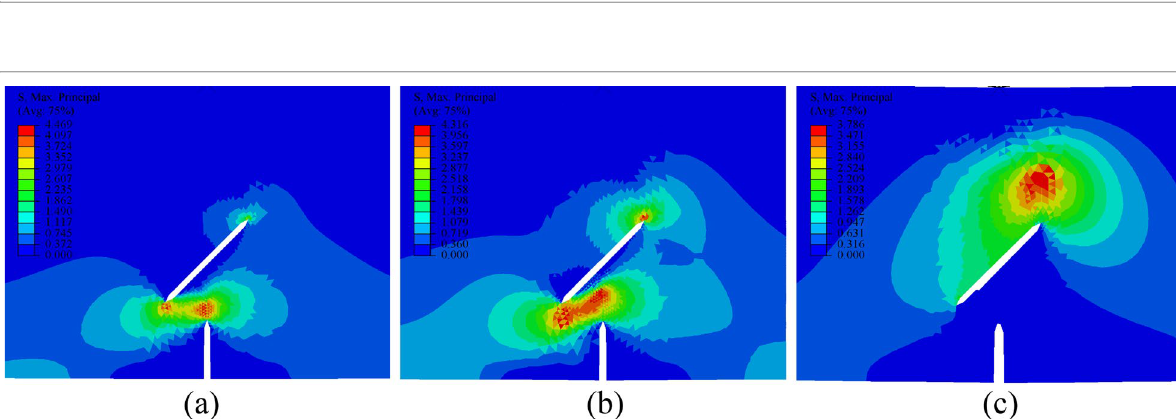
Fig. 21, TPB-A30-T1Y and TPB-A30-T1N represent